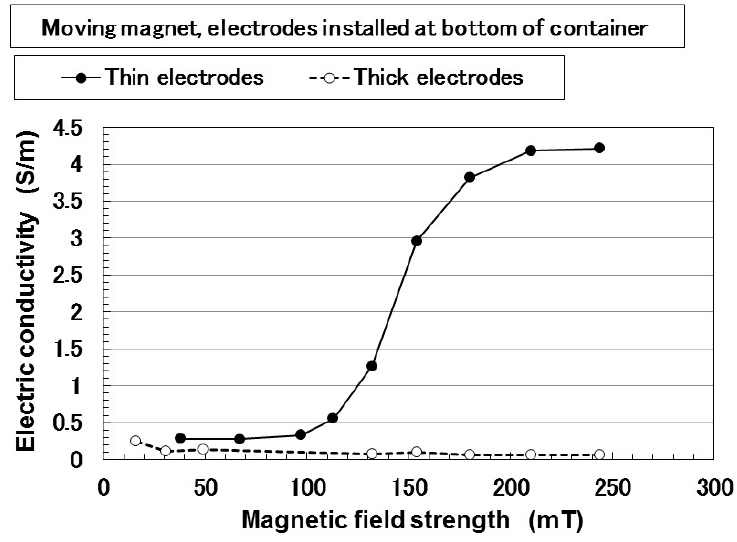
Figure 10. Comparison of electric conductivity between thin and thick electrodes for a moving magnet and with electrodes installed at the bottom of the container.